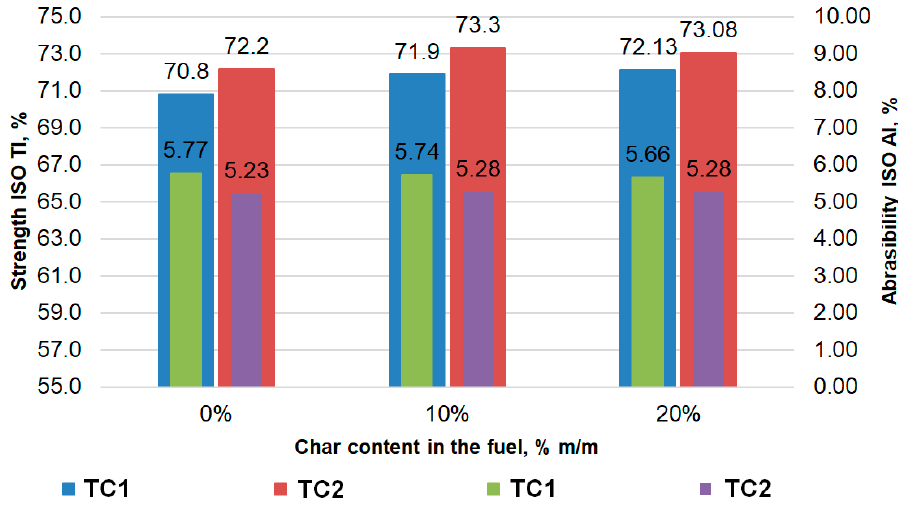
Figure 5. The impact of waste tire char on sinter strength (ISO TI) and abrasibility (ISO AI).